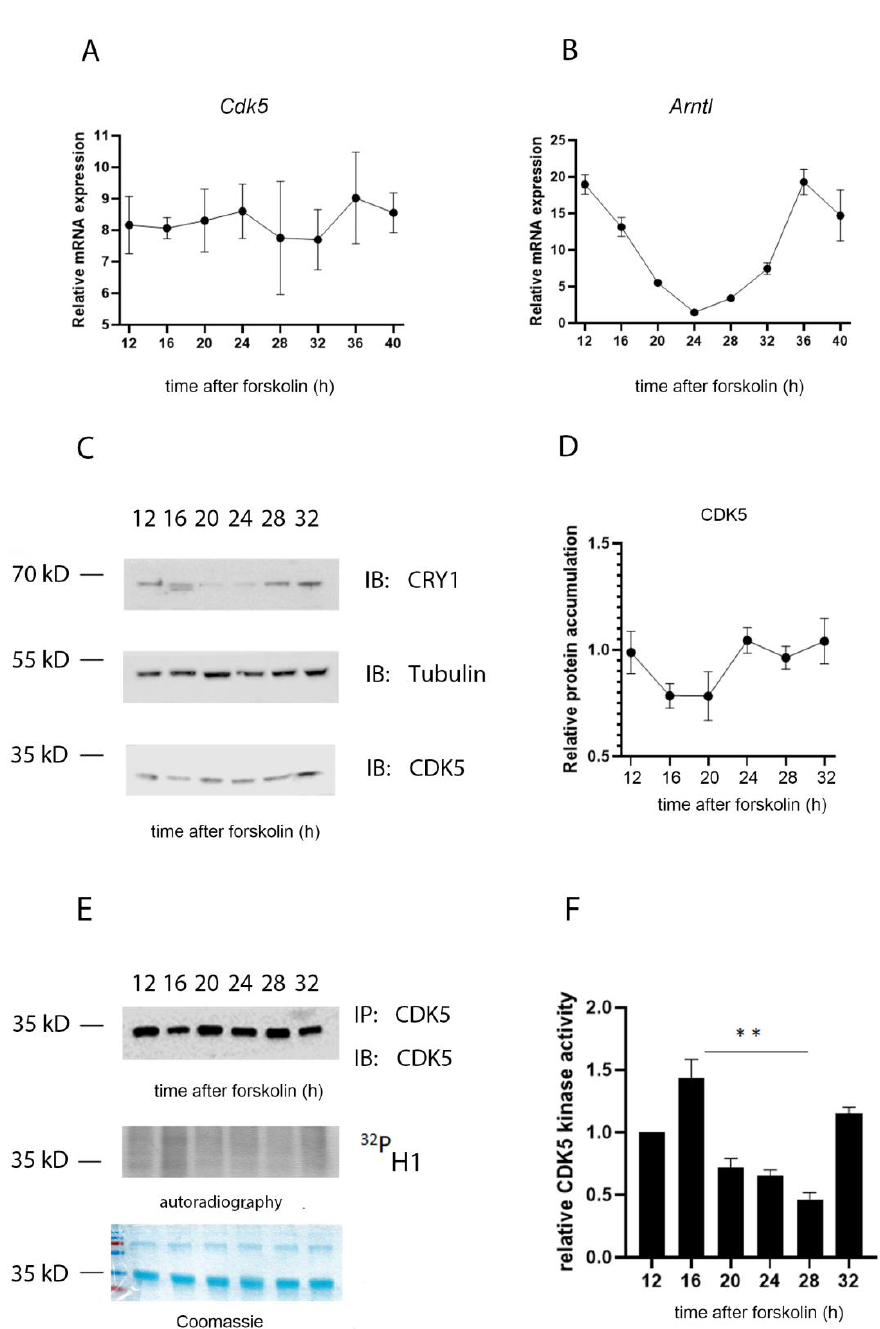
Figure 2. CDK5 kinase activity is circadian. The temporal profile of mRNA induction for Cdk5 ( A ) and Arntl ( B ) was studied in forskolin-synchronized wild-type cells collected at different time points. While Cdk5 gene expression was constant over time, Arntl was oscillating as expected. Quantification of three independent experiments ( n = 3, mean ± SD) was performed. ( C ) Western blot analysis was performed on forskolin-synchronized wild-type cells collected at different time points. To validate the circadian cellular synchronization, samples were detected by WB analysis with an antibody against CRY1. CDK5 detection showed an accumulation over 24 h with mild oscillation. Tubulin was used as a loading control. kD: kiloDalton. ( D ) Quantification of three independent experiments (CDK5/Tub, n = 3, mean ± SD) was performed. ( E ) CDK5 was immunoprecipitated at different time points after forskolin synchronization and, subsequently, an in vitro kinase assay was performed using histone H1 as substrate in the presence of radiolabeled γ 32 P - ATP. ( F ) The radioactive signal was normalized on the immunoblotted signal for CDK5 after the IP. Quantification of three independent experiments ( n = 3, mean ± SD) was performed. One-way ANOVA with Bonferroni’s post-test, *: p <